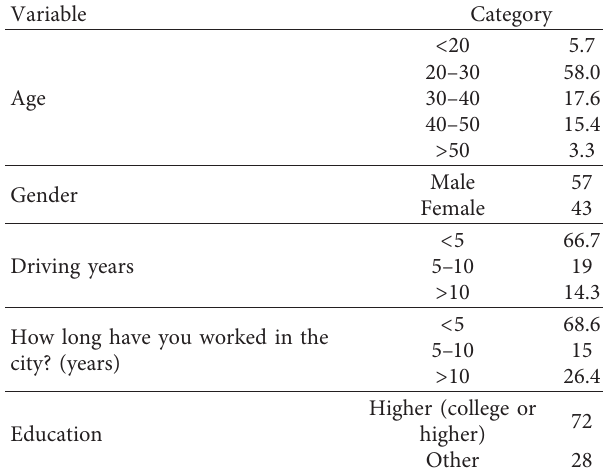
Table 2: Characteristics of